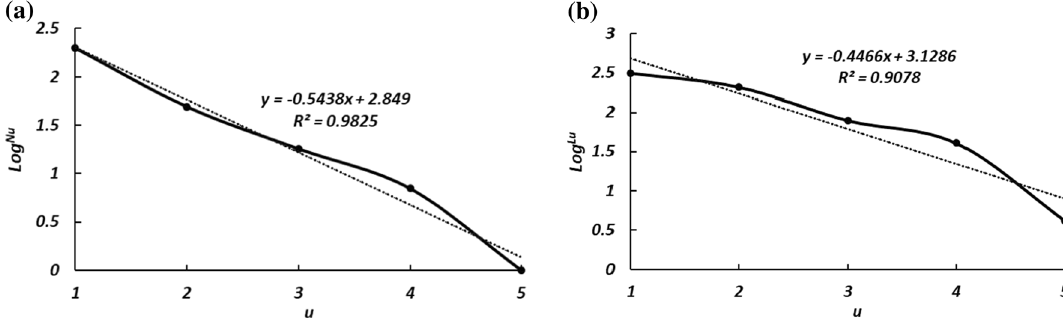
Fig. 3 The relationship between N